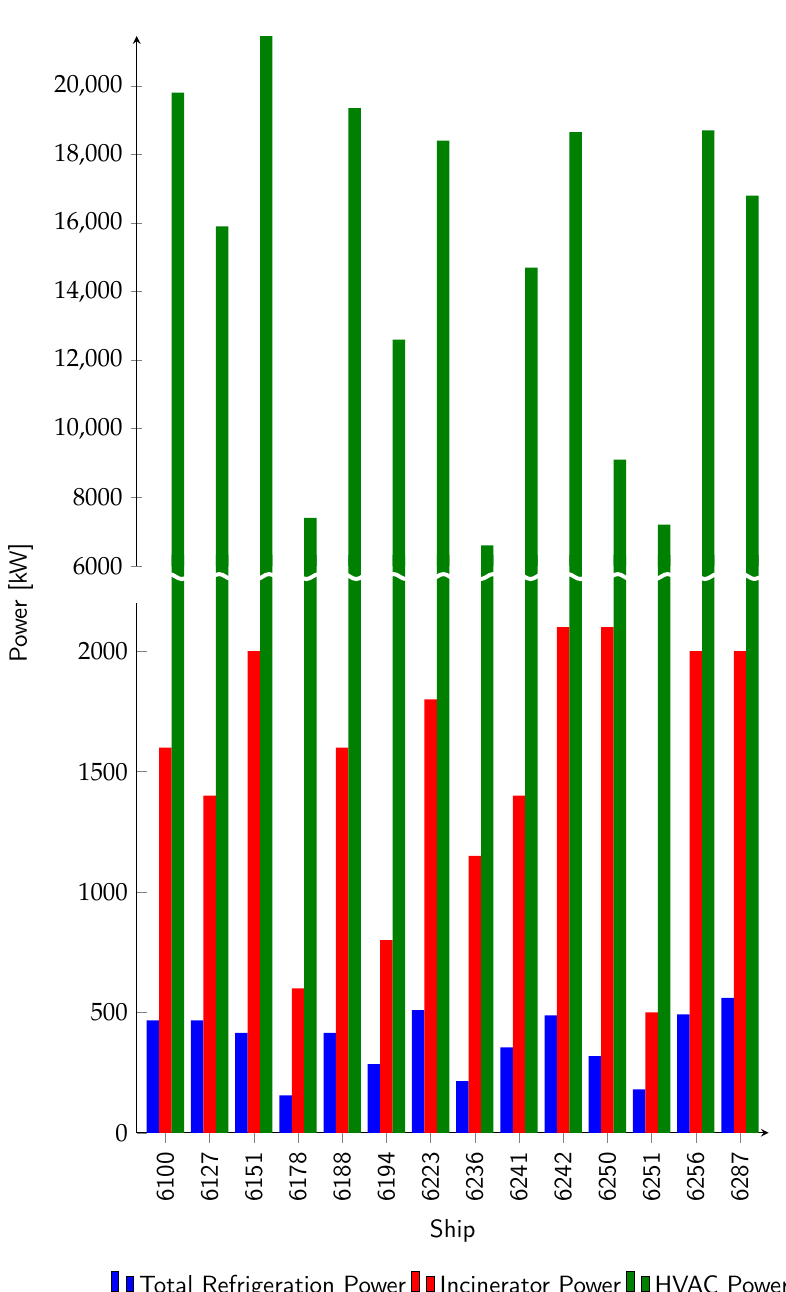
Figure 3. Power of thermal plants onboard different cruise ships, carrying amounts of passen- gers/crew ranging from 800 to 6592 people. The numeric codes in the abscissa axis are internal reference numbers of Fincantieri. for already built and operating cruise